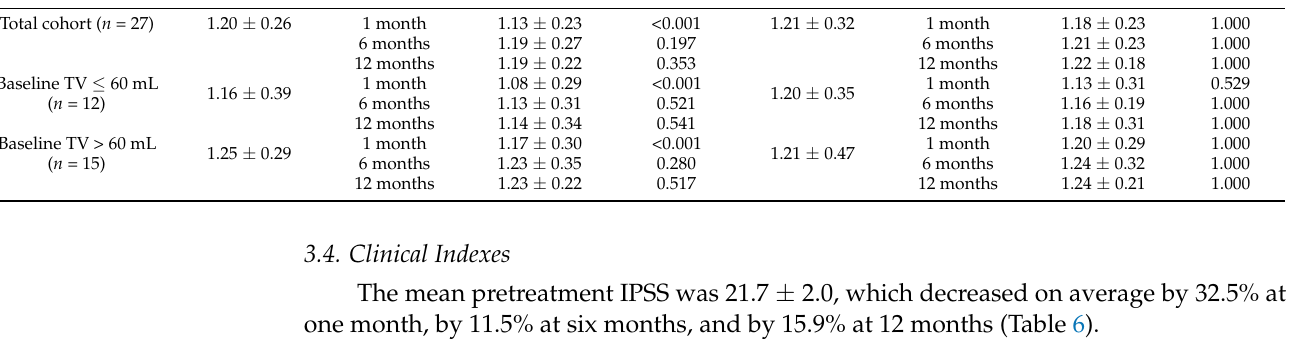
Table 6. Pre- and post-treatment IPSS and ICIQ-UI SF scores. Values presented as means ± SD; p -values include Bonferroni multiple testing